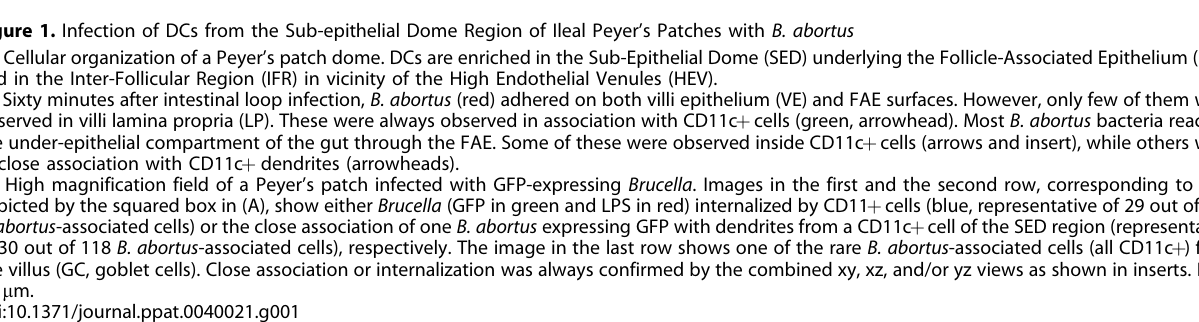
Figure 1. Infection of DCs from the Sub-epithelial Dome Region of Ileal Peyer’s Patches with B. abortus (A) Cellular organization of a Peyer’s patch dome. DCs are enriched in the Sub-Epithelial Dome (SED) underlying the Follicle-Associated Epithelium (FAE) and in the Inter-Follicular Region (IFR) in vicinity of the High Endothelial Venules (HEV). (B) Sixty minutes after intestinal loop infection, B. abortus (red) adhered on both villi epithelium (VE) and FAE surfaces. However, only few of them were observed in villi lamina propria (LP). These were always observed in association with CD11c þ cells (green, arrowhead). Most B. abortus bacteria reached the under-epithelial compartment of the gut through the FAE. Some of these were observed inside CD11c þ cells (arrows and insert), while others were in close association with CD11c þ dendrites (arrowheads). (C) High magnification field of a Peyer’s patch infected with GFP-expressing Brucella . Images in the first and the second row, corresponding to area depicted by the squared box in (A), show either Brucella (GFP in green and LPS in red) internalized by CD11 þ cells (blue, representative of 29 out of 118 B. abortus -associated cells) or the close association of one B. abortus expressing GFP with dendrites from a CD11c þ cell of the SED region (representative of 30 out of 118 B. abortus -associated cells), respectively. The image in the last row shows one of the rare B. abortus -associated cells (all CD11c þ ) from the villus (GC, goblet cells). Close association or internalization was always confirmed by the combined xy, xz, and/or yz views as shown in inserts. Bars, 20 l